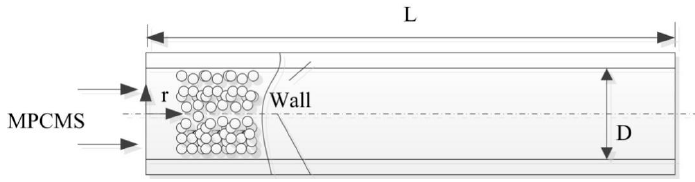
Figure 2. Schematic of MPCMS in a circular tube flow.